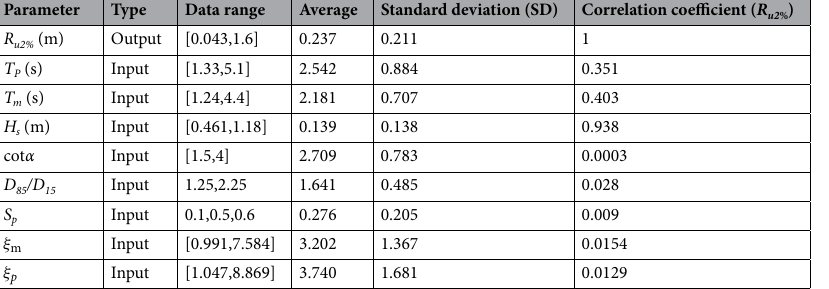
Table 2. Statistical summary of the data used in this study.